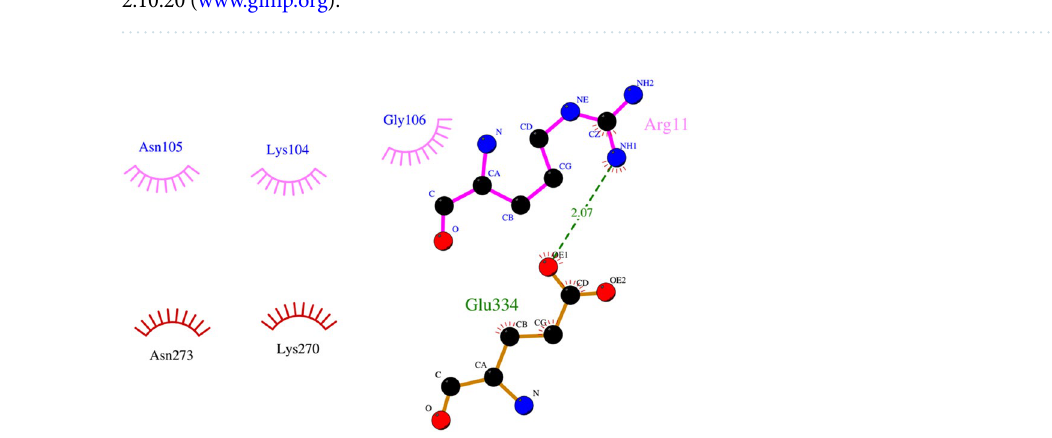
Figure 6. Molecular interactions between CHIKV E1 and PLA CB . 2D diagram of the interactions of the envelope glycoprotein E1 protein with PLA2 CB . The hydrogen bonds (green dashes) are shown between PLA2 CB (purple lines) and E1 glycoprotein (orange lines). Hydrophobic interactions are also shown between PLA2 CB (purple bows) and E1 glycoprotein (red bows). All images were generated using GraphPad Prism 8 and GIMP 2.10.20 (www. gimp. org).